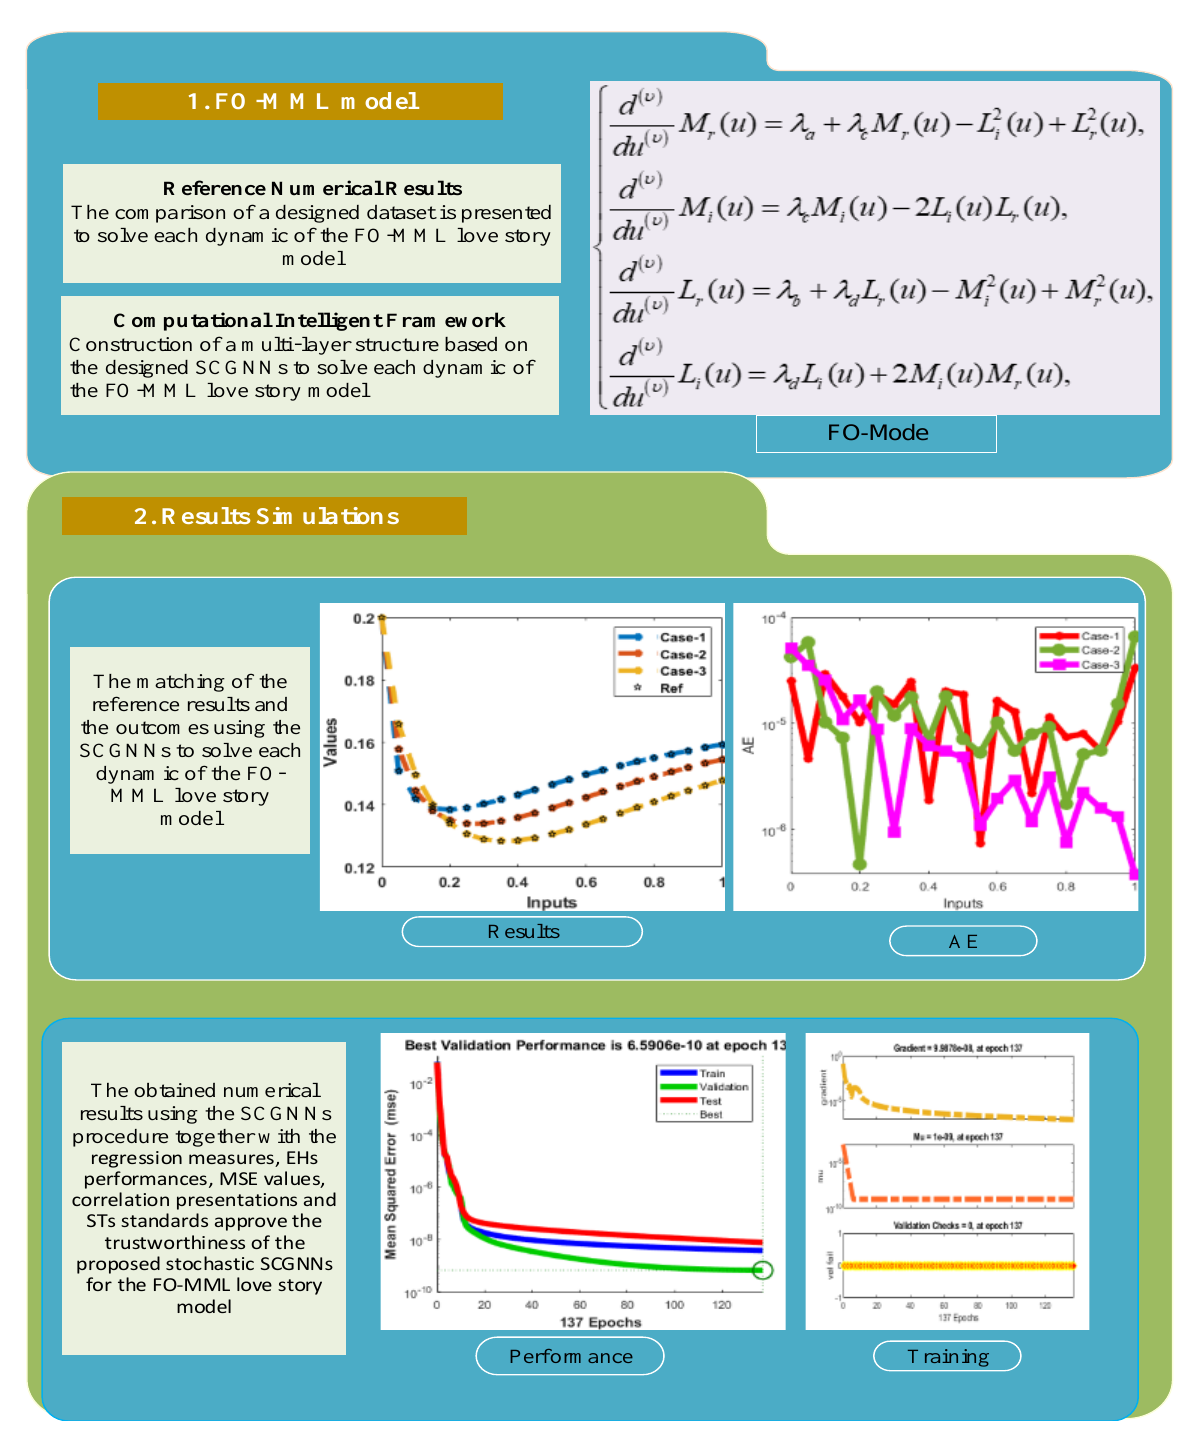
Figure 1. Workflow illustrations of scheme for FO-MML system.